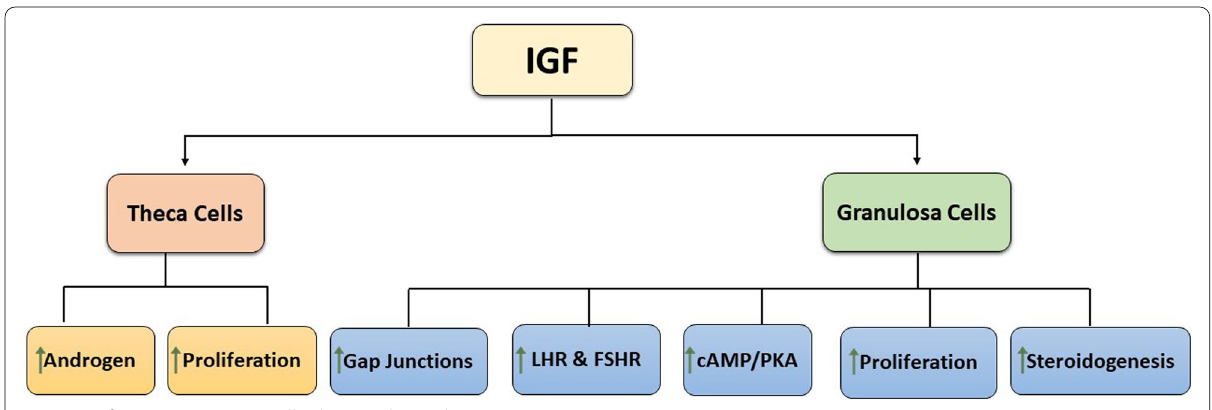
Fig. 1 IGF functions in ovarian cells (theca and